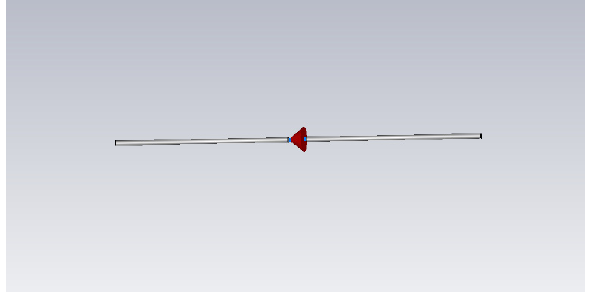
Figure 4. Dipole wire antenna models.